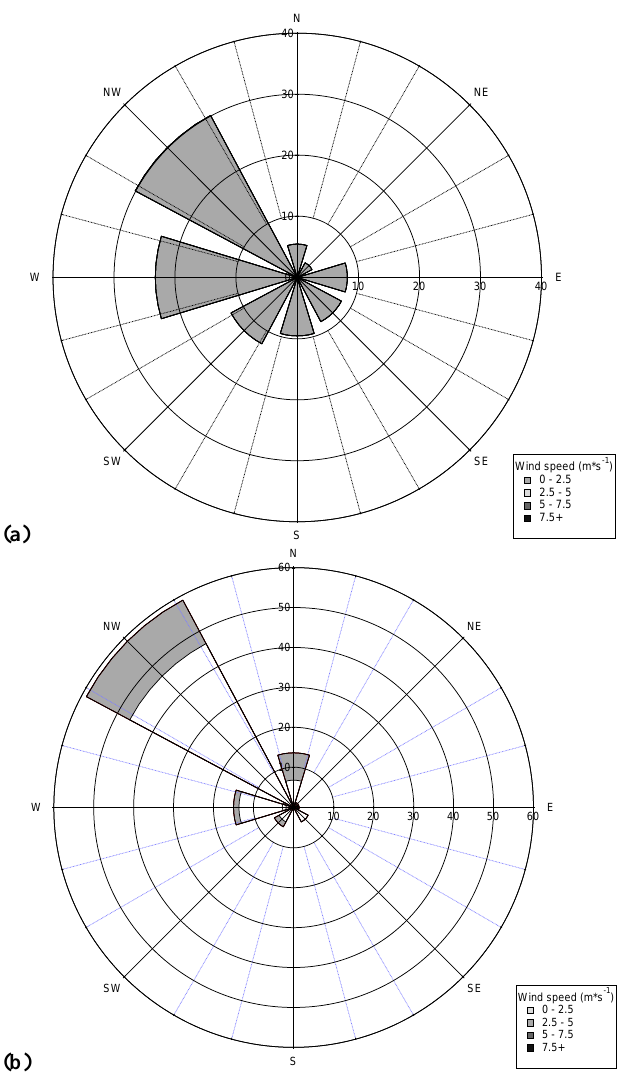
Fig. 2. Wind plots showing the frequency distributions of wind di- rections and speeds (grey scale) of the intensive winter measure- ments for two days: on 9 February (a) and 10 February (b) . The radius axis represents the occurrence from 0% to 40% and from 0% to 60%,